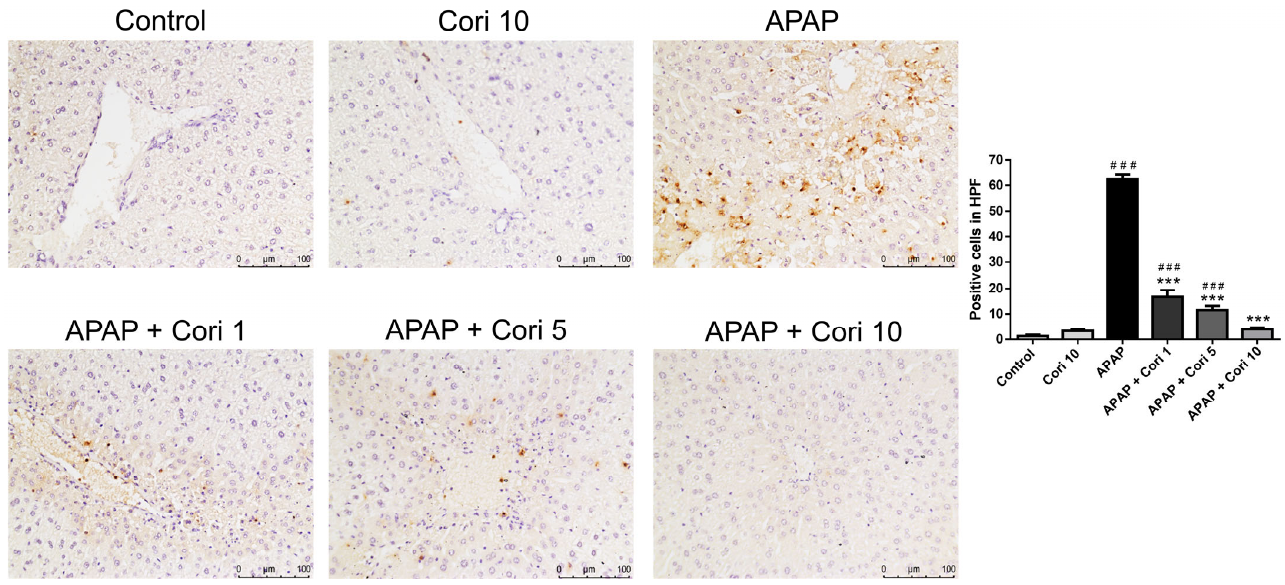
Figure 2. The effects of corilagin on neutrophil infiltration in acetaminophen ‐ induced hepatic injury. Animals were injected with APAP (300 mg/kg) or equal volume of saline (control), and treated with corilagin (0, 1, 5, or 10 g/kg) (200×). Each value represents mean ± SEM; n = 6 for each group. ### p < 0.005 vs. control group; *** p < 0.005 vs. APAP group.